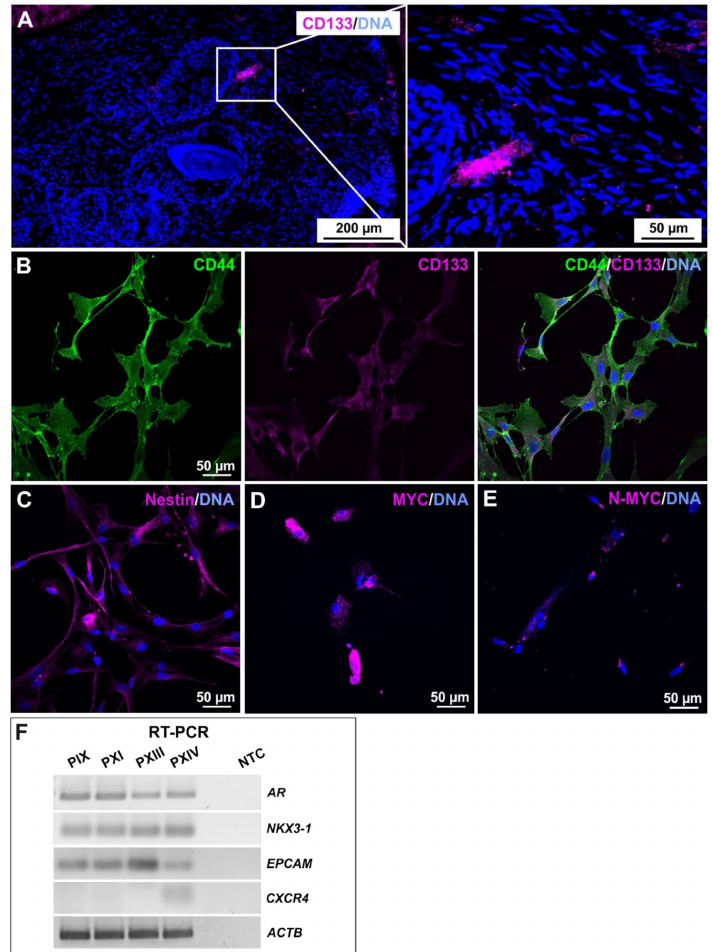
Figure 2. Characterization of stemness properties in primary prostate cancer stem cells. ( A ) Iden- tification of prominin-1 (CD133)-positive cells, localized as a small group of clustered cells after immunohistochemistry of an exemplary prostate cancer section (donor PXI). ( B , C ) Immunocytochem- ical stainings of cancer stem cell (CSC) markers CD44, CD133 and Nestin in the cultured putative prostate cancer stem cell (PCSC) population of PXI. The co-expression of CD44/CD133 revealed the stemness character of primary isolated PCSCs ( B ), further verified by the presence of Nestin ( C ). ( D , E ) Exemplary proto-oncogene MYC and MYC family member N-MYC immunocytochemistry analyses of PIX PCSCs depicted expressions of both CSC-associated markers at the protein level. Nuclear counterstaining was performed using DAPI. ( F ) The further detection of prostate cancer and PCSC markers were carried out on the mRNA level after reverse-transcription (RT) PCR, whereas the androgen receptor ( AR ), prostate cancer-specific gene NKX3-1 , and CSC-related gene epithelial cell adhesion molecule ( EPCAM ) were detected in each PCSC population, the metastasis-associated gene CXCR4 was exclusively detected in PXIV PCSCs. Beta actin (ACTB) served as the housekeeping